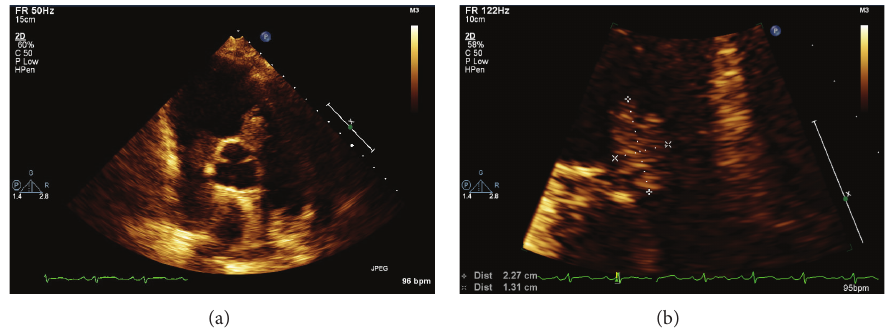
Figure 1: Transthoracic echocardiogram parasternal short axis showing a 2.2 × 1.31 cm echodensity on the pulmonic valve.